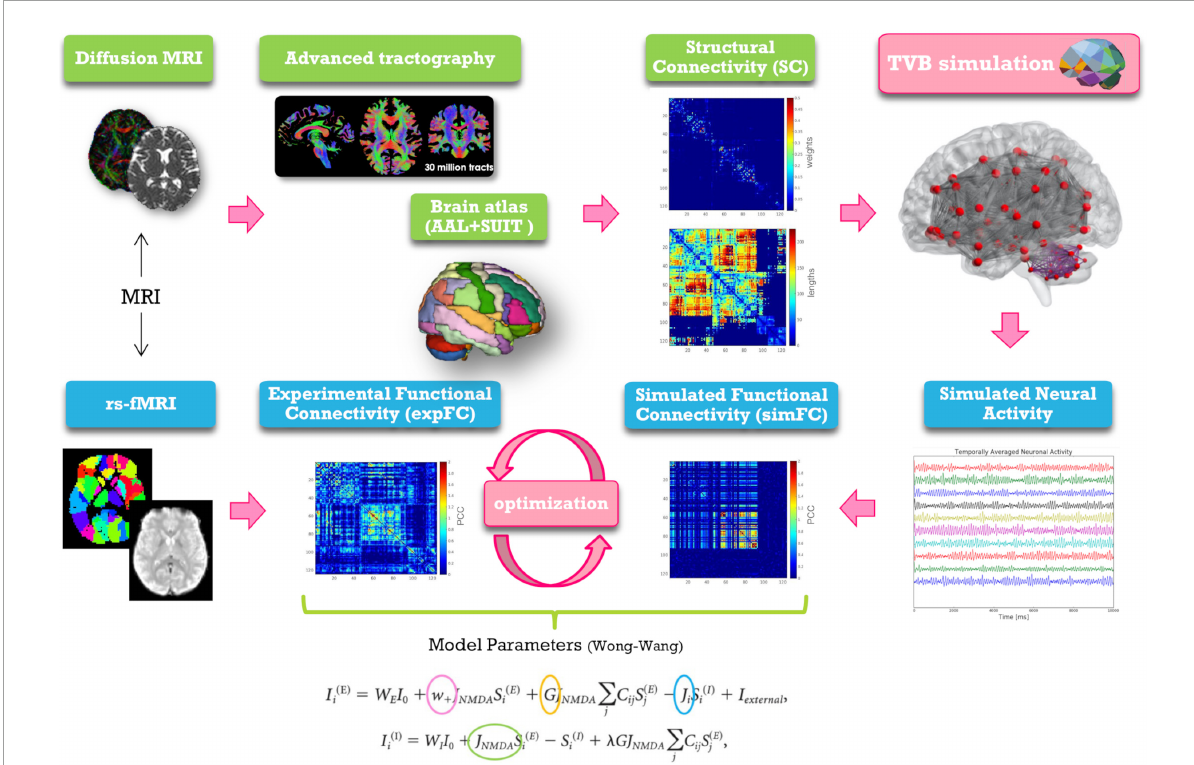
FIGURE1 Schematic representation of modeling workflow. MRI is used to obtain the structural and experimental functional connectivity matrices (SC and expFC) needed for TVB construction and optimization. From top left, clockwise: diffusion weighted images are preprocessed and elaborated to yield whole-brain tractography. An ad hoc parcellation atlas combining AAL atlas and SUIT is used to map the SC matrices obtained from whole-brain tractography parcellation (top weight matrix, bottom distance matrix). The Virtual Brain (TVB) is constructed using the SC matrix for edges and neural masses for nodes. TVB simulations of neural activity allow to extract BOLD signals for each node leading to define the simulated functional connectivity (simFC) matrix . TVB optimization is performed through model inversion by comparing the simFC with the expFC. Model parameters, highlighted with circles, and the corresponding equations are shown at the